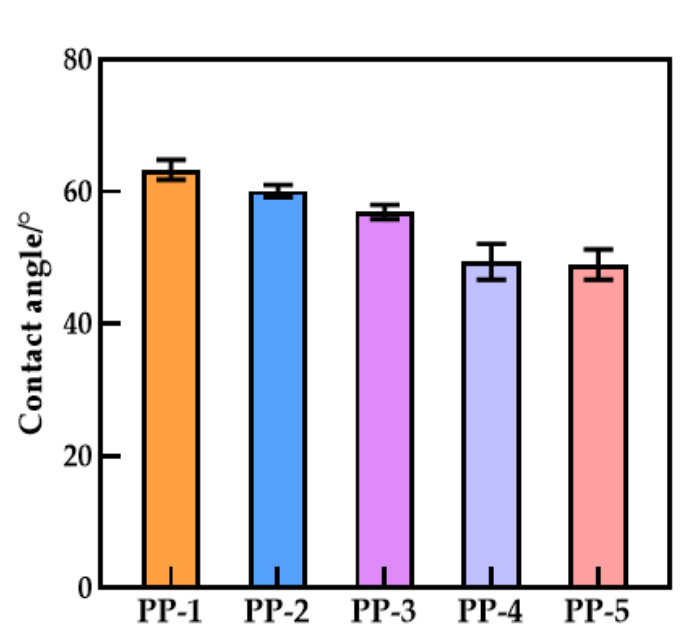
Figure 10. Contact angle of various PES/PEI membranes.